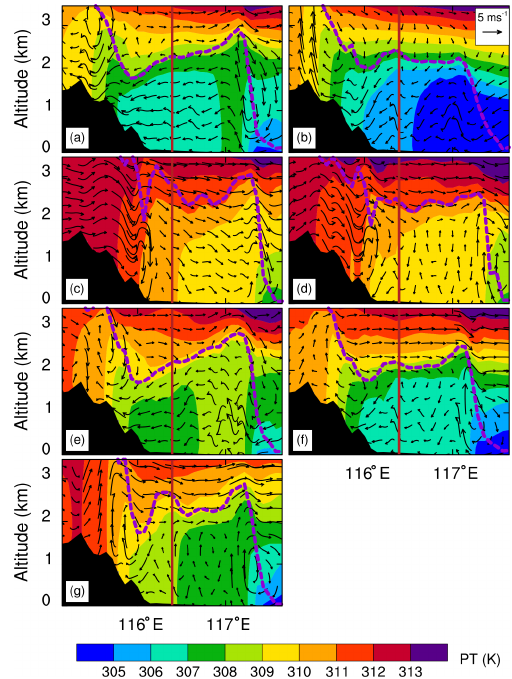
Figure 11. Vertical cross sections of the PT and wind vectors at 14:00BJT for the seven synoptic pattern types: (a) Type 1, (b) Type 2, (c) Type 3, (d) Type 4, (e) Type 5, (f) Type 6, and (g) Type 7. The vertical wind component is multiplied by a factor of 30 when plotting the wind vector fields. The black area on the left side of each panel shows the terrain. The red line shows the location of the sounding station in Beijing. The violet dashed line marks the BLH estimated using the Ri method. The location of the cross section is shown by the red line in Fig.